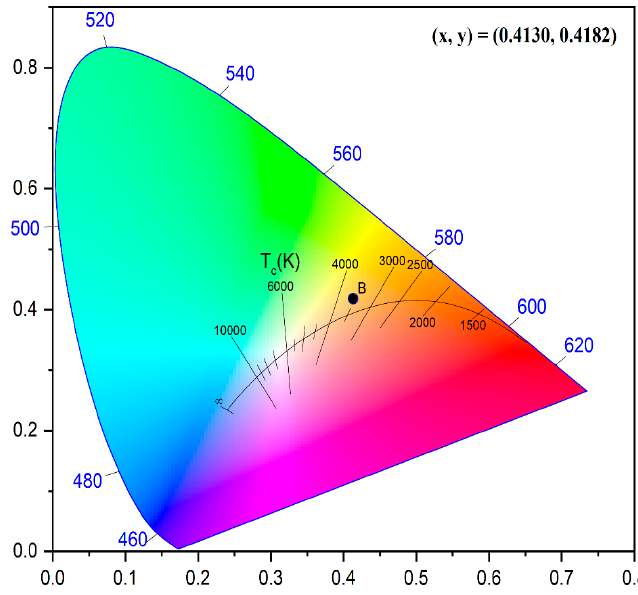
Figure 8. 1931 CIE diagram of Co-doped ZnO/CdS nanosheets.